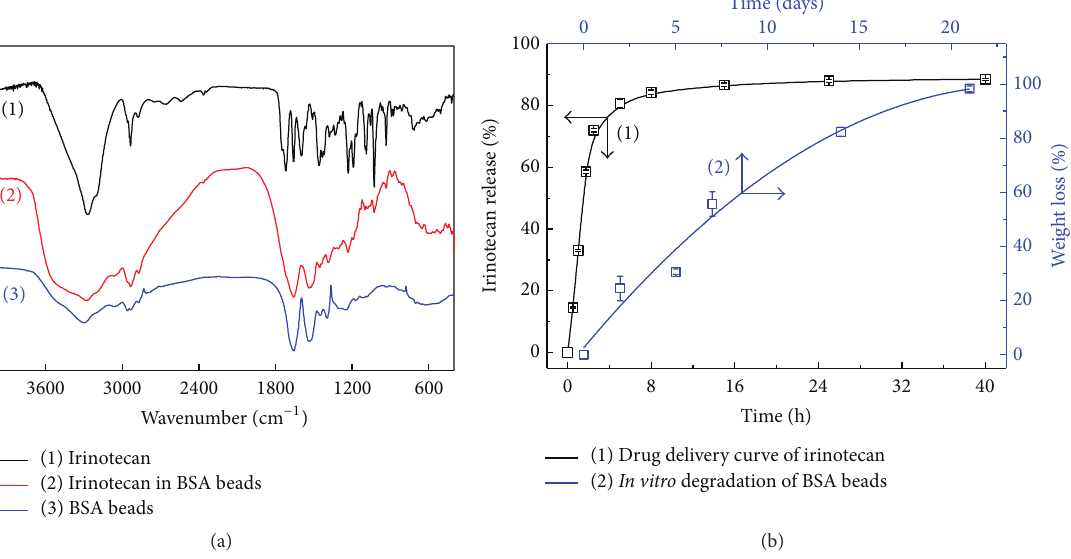
Figure 3: (a) FTIR characterizations of irinotecan, BSA beads, and irinotecan loaded BSA beads; (b) irinotecan release curve from cross- linked BSA beads and the weight loss of BSA loaded BSA beads caused by degradation of